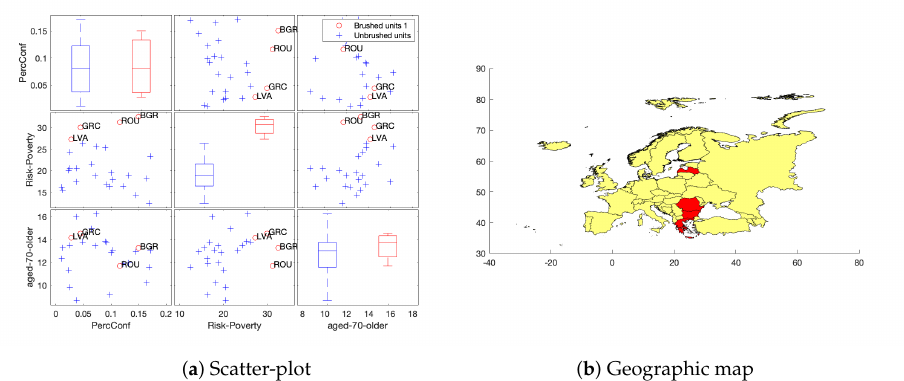
Figure 6. Exploratory step: Data brushing on multiple scatter-plot and box-plots to highlight countries on a map: points highlighted on scatter-plots are colored in red on the map. Wave 3. Figure 7 contains the graphical output of the FS-DB algorithm for outlier detection in datasets of mixed data. Left panels show the Forward-plots and right panels contain the MDS-plots. To produce these plots, all the variables in the dataset were used, and distance between countries was measured using our proposal for robust Gower